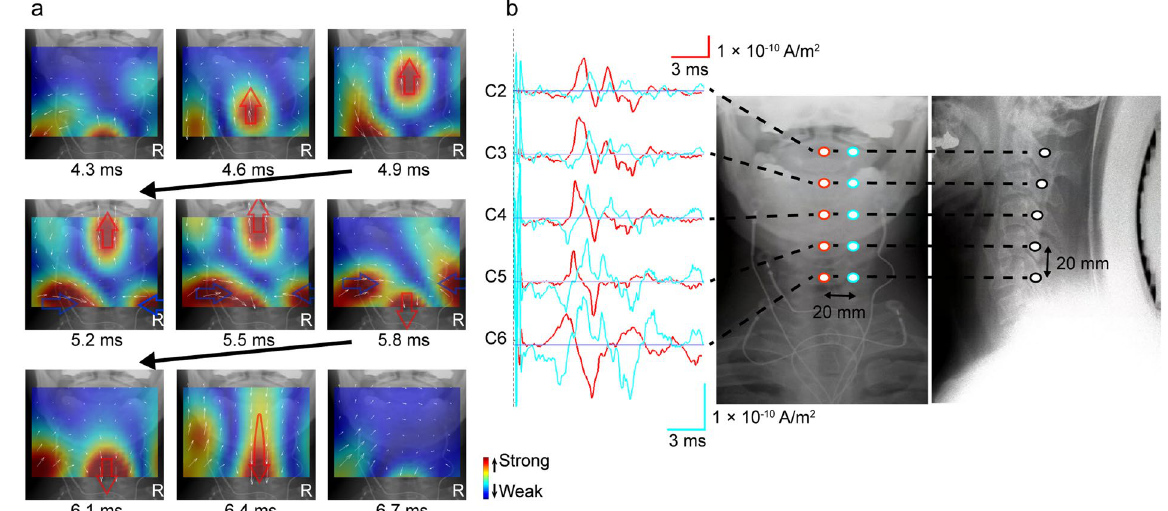
Figure 2. Reconstructed currents of a healthy subject measured after stimulation of the lower thoracic spinal cord. ( a ) Reconstructed current map. Currents at the level of the spinal canal were reconstructed by a recursive null-steering (RENS) beamformer and superimposed on an X-ray image. Current intensity is shown by a colour scale (red is higher). Small white arrows indicate current vectors. The leading component of the currents (large upwards-pointing red arrow) appeared 4.3 ms after stimulation and propagated cranially along the spinal canal. At 5.8 ms, the trailing component (downwards-pointing red arrow) appeared from the caudal side. Perpendicular currents (blue arrows) flowing towards the spine between the leading and the trailing components are also observed on both sides. ( b ) Waveforms of reconstructed currents at the “virtual electrodes”. Red traces are currents at the midline of the cervical spinal canal (the caudal to cranial direction is upwards). Blue traces are currents 20 mm lateral from the midline (upwards is towards the spinal canal).